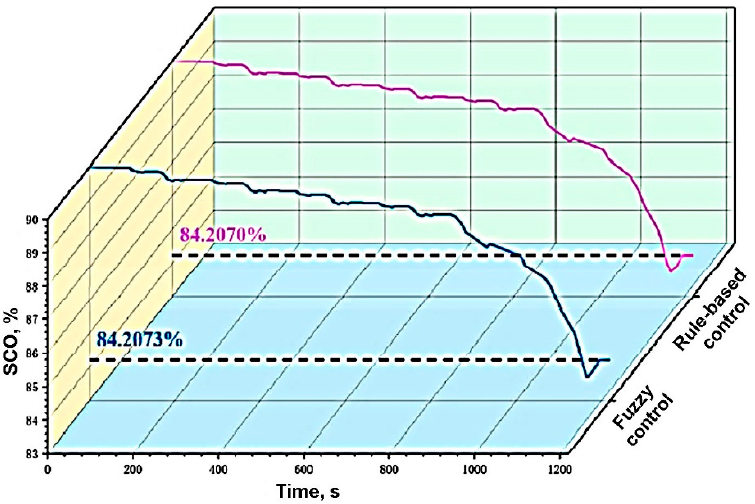
Figure 13. Fuzzy optimization analysis: battery SOC curve.